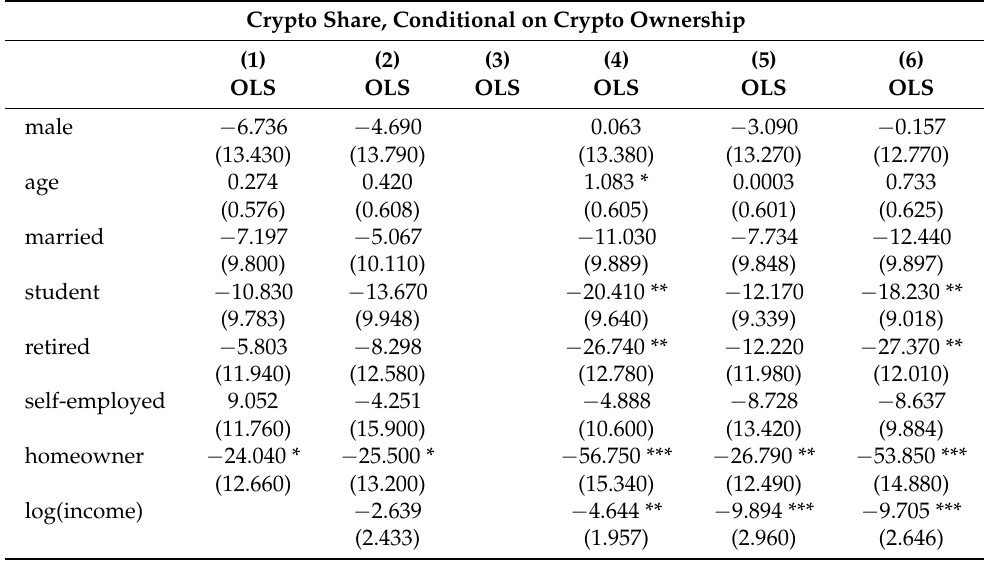
Table 6. OLS regression of crypto share in users’ portfolio. Source: Own